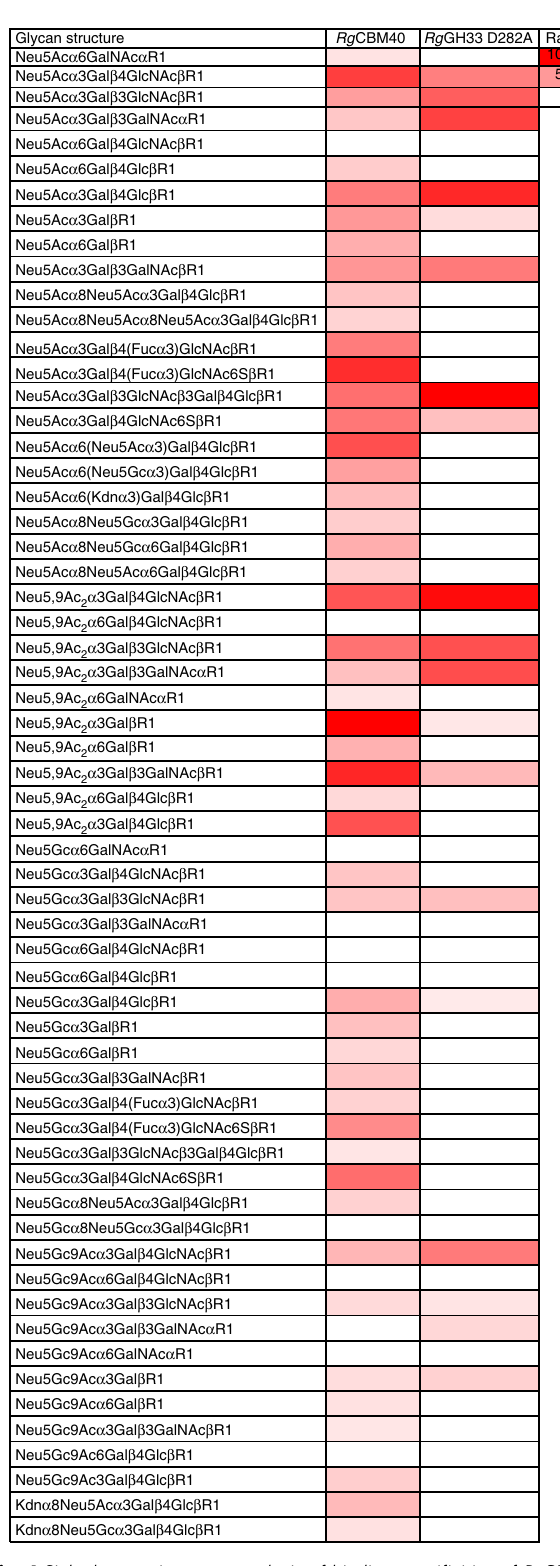
Fig. 4 Sialoglycan microarray analysis of binding speci fi cities of Rg CBM40 and Rg GH33 D282A. Binding of the recombinant proteins Rg CBM40 and Rg GH33 D282A at 20 and 200 µ g ml − 1 , respectively are presented ( n = 4, SD). Heat map was generated using the method as previously described 38,39 . Binding was ranked as (glycan average RFU/ maximum glycan average RFU)×100. Red and white represent the maximum and minimum, respectively. R1 represents propyl-azide as the